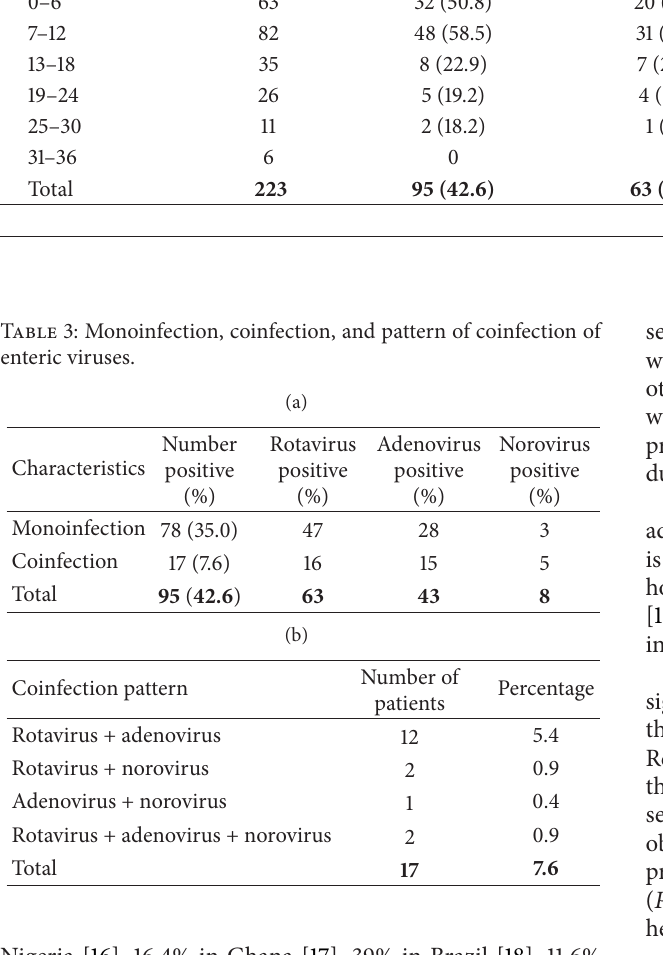
Characteristics